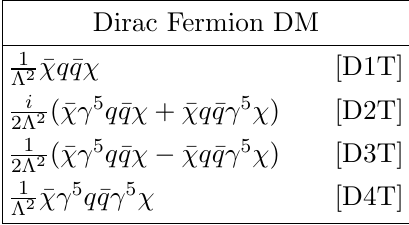
Table 2 . Additional EFT operators, non-linearly-independent from those in table